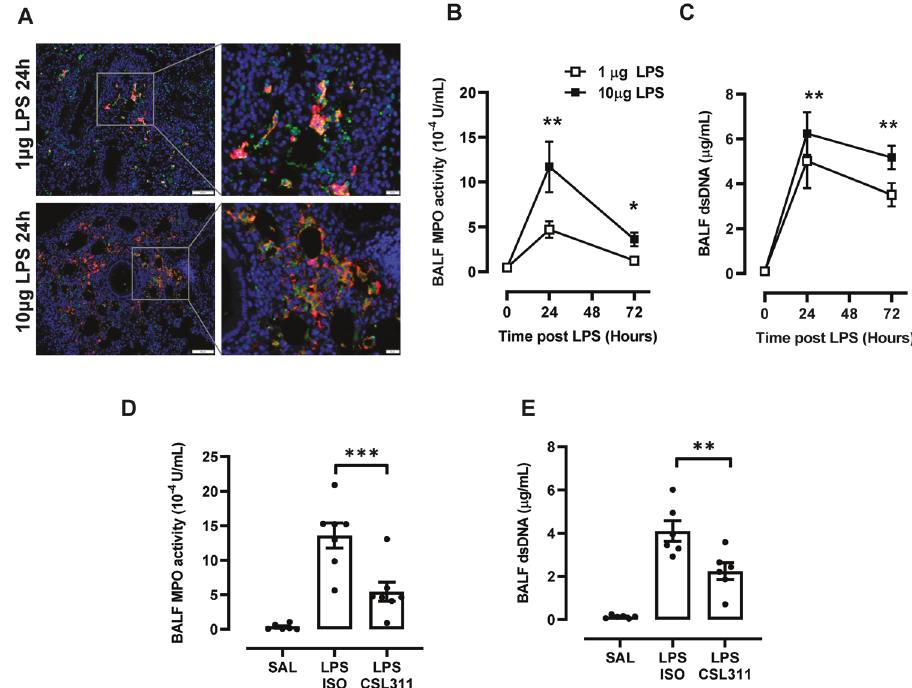
Fig. 4 CSL311 signi fi cantly reduces netosis in response to LPS challenge in h β c Tg mice. A Co-localisation of MPO (green) and histone H3 (red) staining identi fi ed lung netosis, which was more prominent with high dose LPS (10 μ g). B MPO activity and ( C ) dsDNA levels were quanti fi ed in the BAL- fl uid. D MPO activity and ( E ) dsDNA in BALF were signi fi cantly reduced with CSL311 treatment. n = 6 – 7; data are Mean ± SE; * p < 0.05, two-way